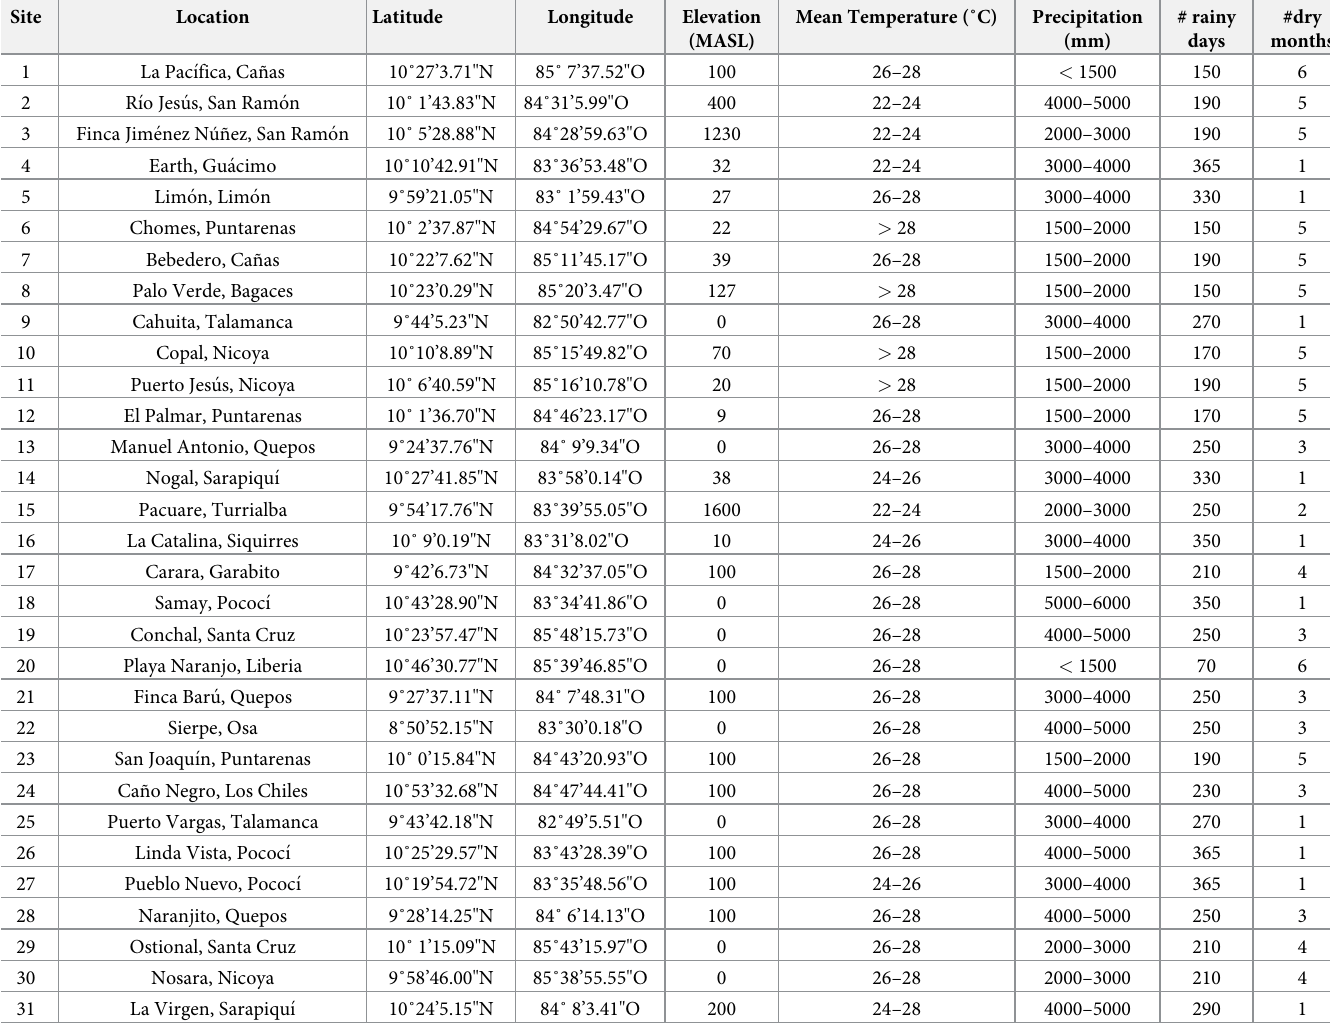
Table 1. Attributes of climatic zones of the study areas of non-human primates, Costa